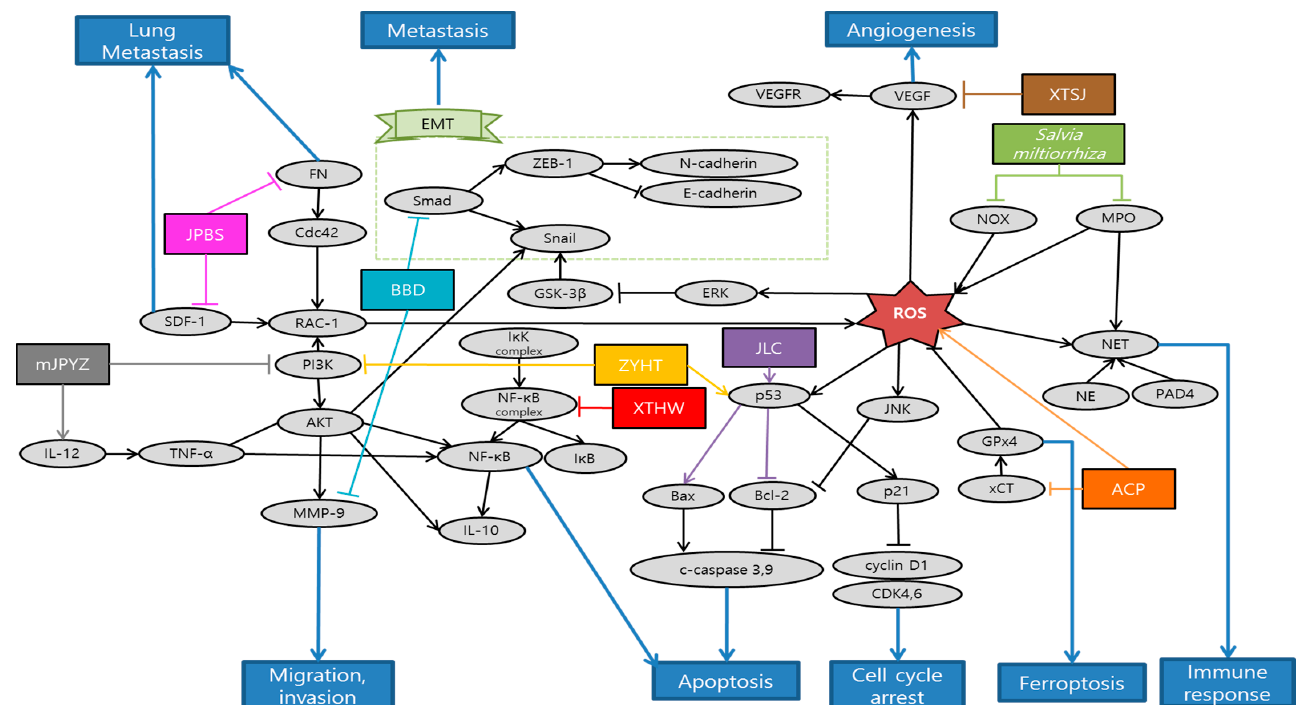
Figure 3. Schematic diagram of anti-metastatic mechanisms of herbal medicine in gastric cancer: When it comes to ROS, it has double-edged aspects in anti-tumor efficacy and mechanisms. Therefore, there are also two opposite ways that natural antioxidants utilize ROS as part of anti-metastatic process. First of all, ROS is predominantly generated by NOX as an early response to phagocytosis-mediated microbicidal activity of neutrophils. There exists a complicated enzymatic cascade of NOX, protein-arginine deiminase 4 (PAD4), neutrophil elastase (NE) and MPO which plays a crucial role in triggering sequential generation of neutrophil extracellular traps formation (NETosis) for circulating tumor cells and metastasis. Natural antioxidants might be applied as an effective antitumor agent in preventing early phase of NETs as a result of ROS. In contrast, herbal medicine can promote ferroptosis by maximizing ROS. Abbreviated expressions of glutathione peroxidase 4 (GPx4) and cystine/glutamate antiporter (xCT), inducing the ROS accumulation in human gastric cancer (HGC) cells 27, finally aggravate the ferroptosis of cancer cells. Furthermore, herbal medicine can inactivate the metastasis related process. TGF- β activates the Smad signaling pathway, which shares a common EMT pathway. SDF-1 and FN proteins are key factors in pre-metastatic niche formation in the lung, which lead to Cdc42 and Rac-1 expression. Besides, herbal medicines stimulate cancer cell apoptosis related processes. For instance, PI3K/AKT/NF- κ B signaling pathway is related to potential mechanisms for proliferation and apoptosis. Executive caspase-3, which is activated by up-regulated Bax or down-regulated Bcl-2, can also induce apoptosis. Abbreviation: ACP, Actinidia chinensis Planch; BBD, Babao Dan; DKT, Daikenchuto; JPBS, Jianpi Bushen; mJPYZ, modified Jian-pi-yang-zheng; JLC, Jinlong Capsule; XTHW, Xiao Tan He Wei; XTSJ, Xiaotan Sanjie; ZYHT, ZiYinHuaTan.